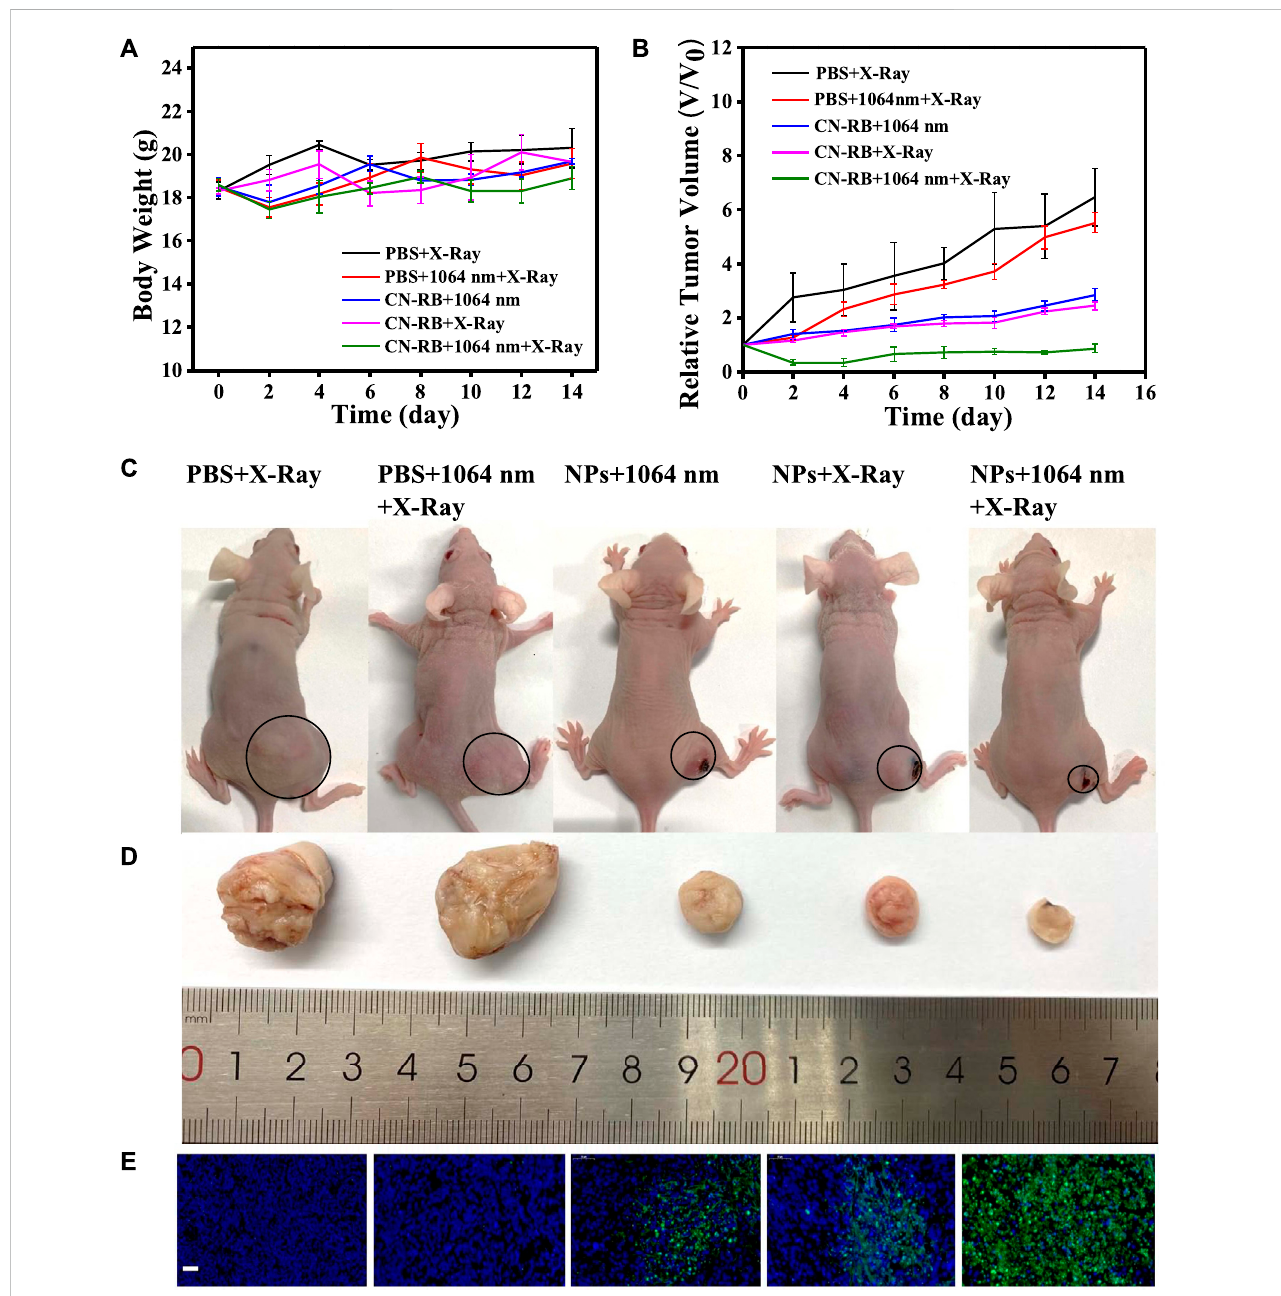
FIGURE 4 (A) Body weights of 4T1-tumor-bearing BALB/c nude mice with different treatments. (B) Tumor volumes of 4T1-tumor-bearing BALB/c nude mice with differenttreatments. (C) Digitalphotographsof fi vegroupsof4T1-tumor-bearingBLAB/cnudemiceandtumorsarecircled( n =3). (D) Correspondingimages ofexcisedtumorsfrom4T1-tumor-bearingBLAB/cnudemiceafter14 daystreatment. (E) TUNELassayoftumorslicesofdifferentgroupsafter14 days,green fl uorescence represents apoptotic cells. (the scale bar is 50 μ